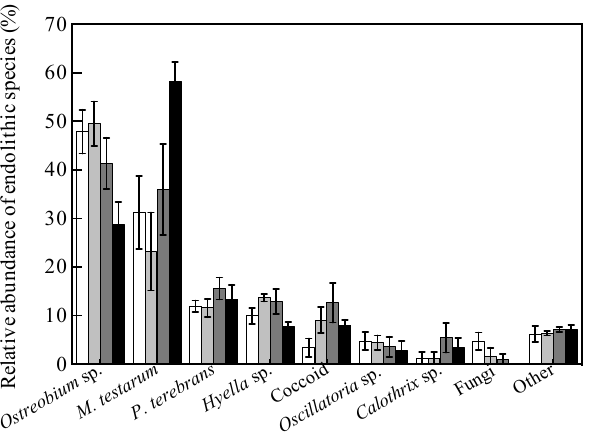
Figure 3. Photosynthetic microborers in CCA skeletons. (a) Biomass of photosynthetic microborers (mgcm − 2 ) . (b) Relationship between biomass of microborers (mgcm − 2 ) and dissolution rate (mgCaCO 3 cm − 2 d − 1 ) . Data correspond to means ± SEM ( n = 12 per p CO 2 -T Fig 3. Photosynthetic microborers in CCA skeletons. (A) Biomass of photosynthetic treatment). p CO 2 -T levels correspond to pre-industrial (320µatm, 23 ◦ C), present-day (410µatm, 24 ◦ C), reduced (600µatm, 26 ◦ C), and business-as-usual (1000µatm, 28 ◦ C) CO 2 emission scenarios. The dashed line represents the linear regression of the complete data set, and microborers (mg cm -2 ). (B) Relationship between biomass of microborers (mg cm -2 ) and the solid line corresponds to the relationship for the A1FI p CO 2 -T scenario. dissolution rate (mg CaCO cm -2 d -1 ). Data correspond to means ± s.e.m (n = 12 per p CO -T 3 2